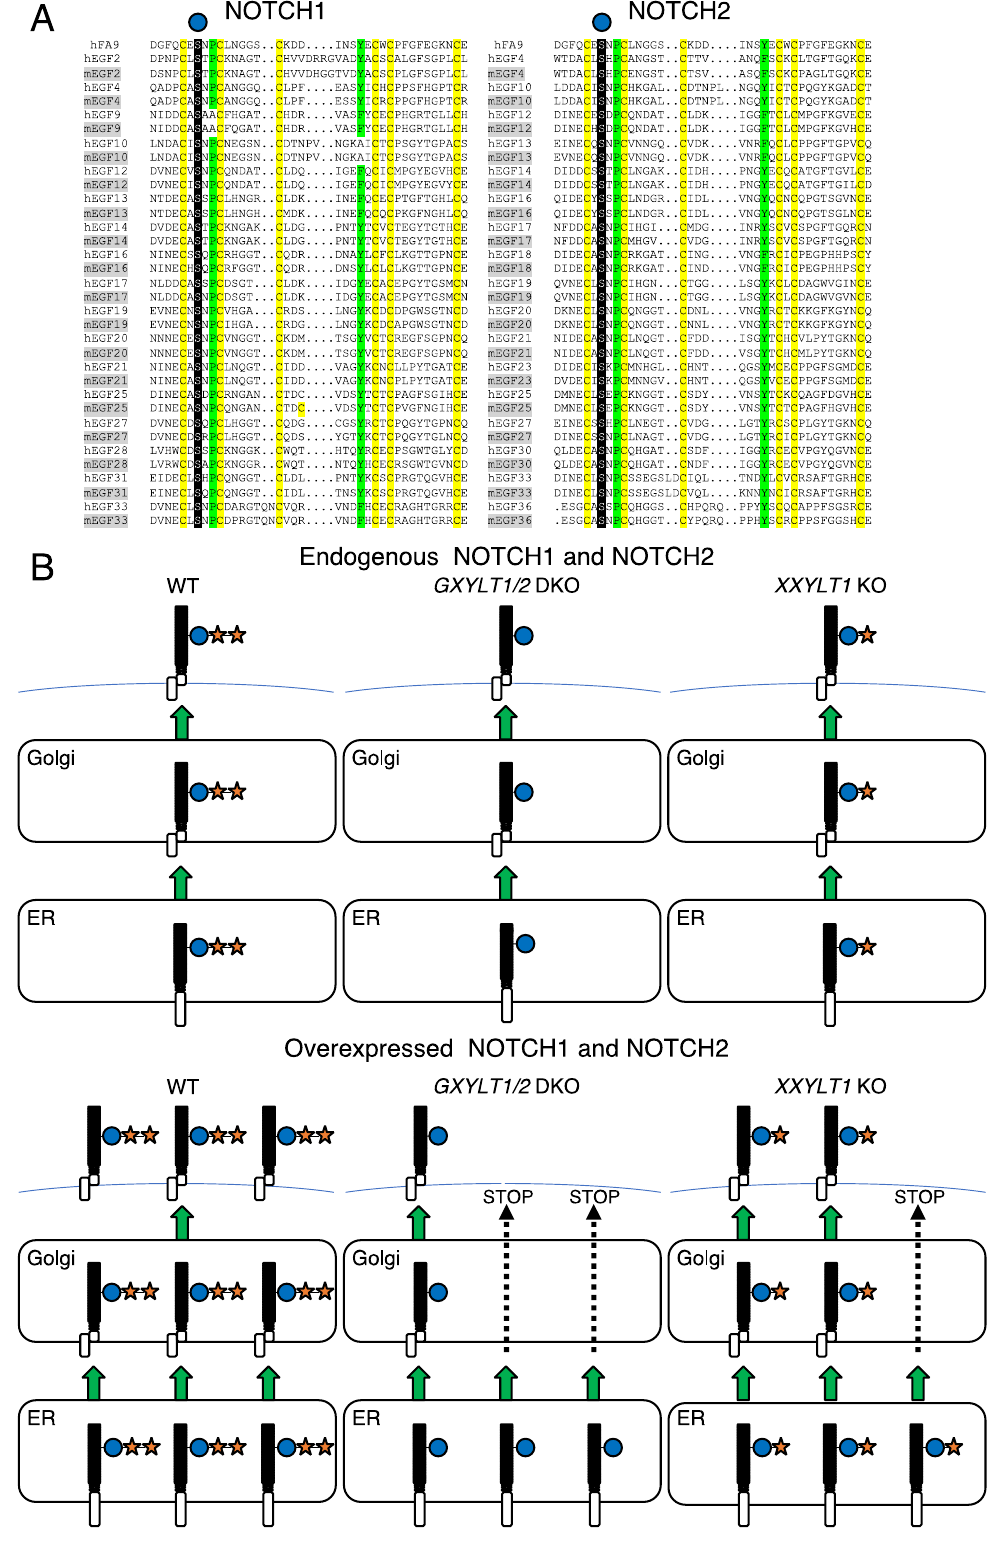
Figure 7. The potential role of xylosyl extension of O -Glc glycans in the quality control of NOTCH1 and NOTCH2. ( A ) Sequence alignment of all 17 EGF repeats of human and mouse NOTCH1 (left column) and NOTCH2 (right column) harboring the O -Glc consensus sequence with the EGF repeat 1 from human factor IX (hFA9). The O -Glc modification site within the consensus sequence is highlighted in black and indicated with a blue circle. Six conserved cysteine residues are highlighted in yellow. An O -Glc trisaccharide is shown to interact intramolecularly with the hydrophobic region